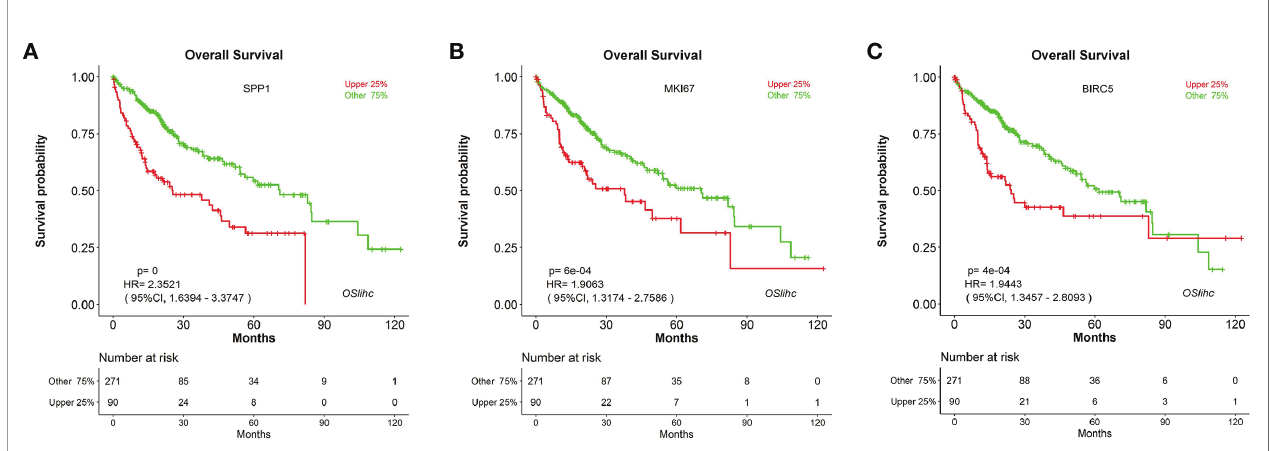
FIGURE 4 | Validation of the top three high-frequency reported biomarkers in OSlihc. Kaplan – Meier plots for (A) SPP1 , (B) MKI67 , and (C) BIRC5 in terms of OS. p -value, con fi dence interval (95%CI) and number at risk are as shown. The y-axis represents survival rate and the x-axis represents survival time (months). p = 0 denotes p <